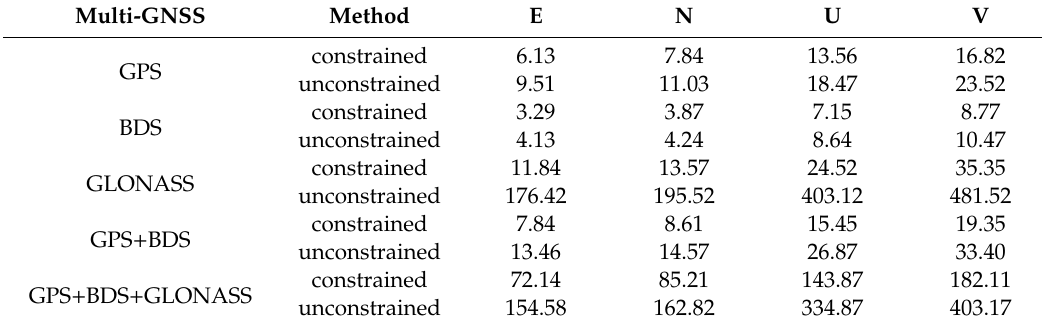
Table 2. Internal accuracy statistics of the S012 monitoring site for the E, N, U and total displacement V directions (in